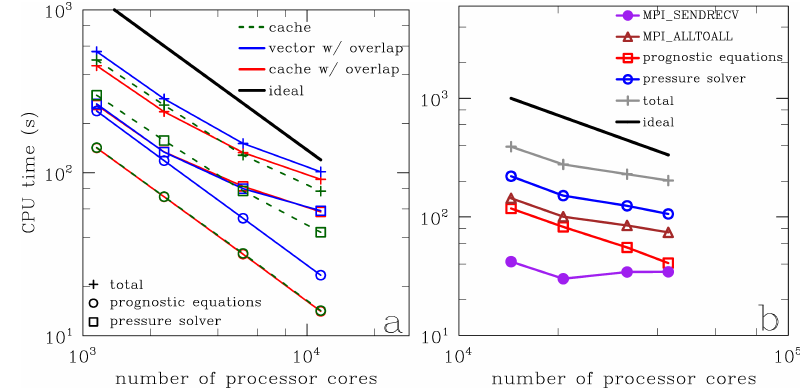
Figure 12. Scalability of PALM 4.0 on the Cray XC40 supercomputer of HLRN. Simulations were performed with a computational grid of (a) 2160 3 and (b) 4320 3 grid points (Intel-Ivy Bridge CPUs). (a) shows data for up to 11520 PEs with cache (red lines) and vector (blue lines) optimization and overlapping during the computation (FFT and tri-diagonal equation solver, see Sect. 4.4) enabled (dashed green lines). Measurement data are shown for the total CPU time (crosses), the prognostic equations (circles), and for the pressure solver (boxes). (b) shows data for up to 43200 PEs and with both cache optimization and overlapping enabled. Measurement data are shown for the total CPU time (gray line), pressure solver (blue line), prognostic equations (red line), as well as the MPI calls MPI_ALLTOALL (brown line) and MPI_SENDRCV (purple